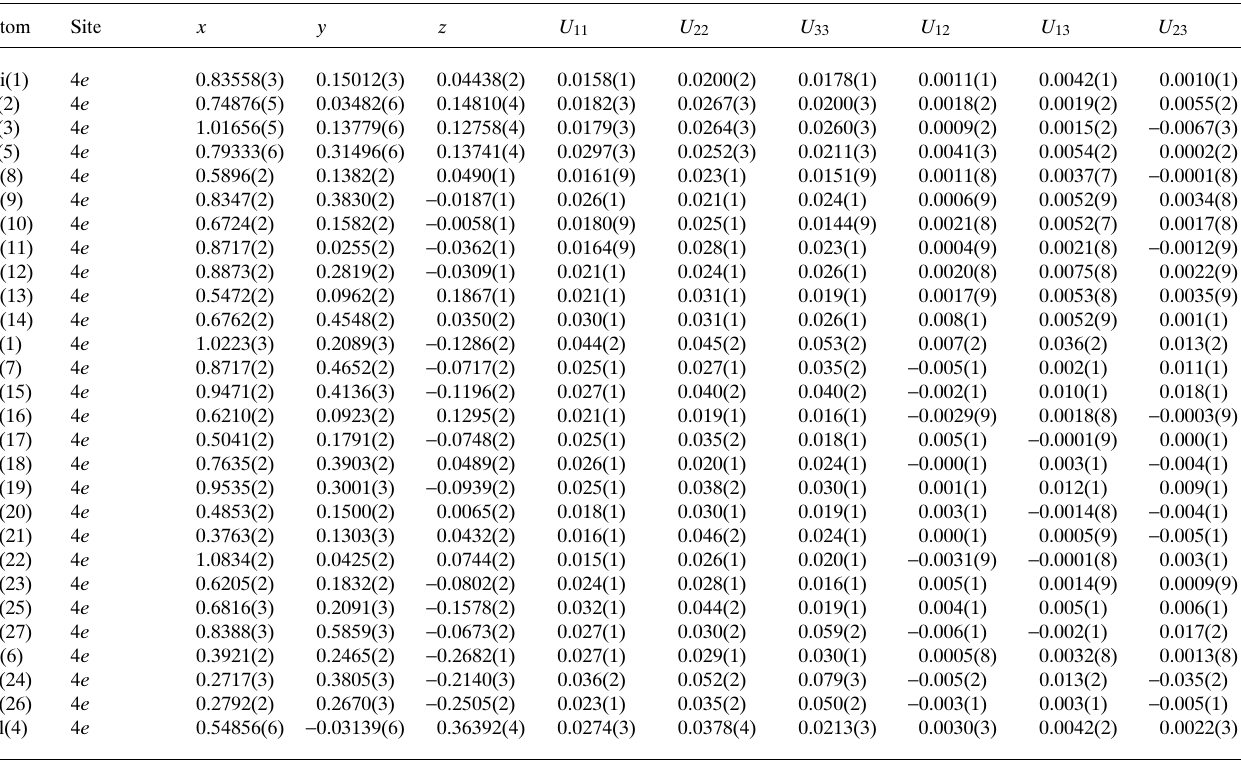
Table 3. Atomic coordinates and displacement parameters (in Å 2 ) .